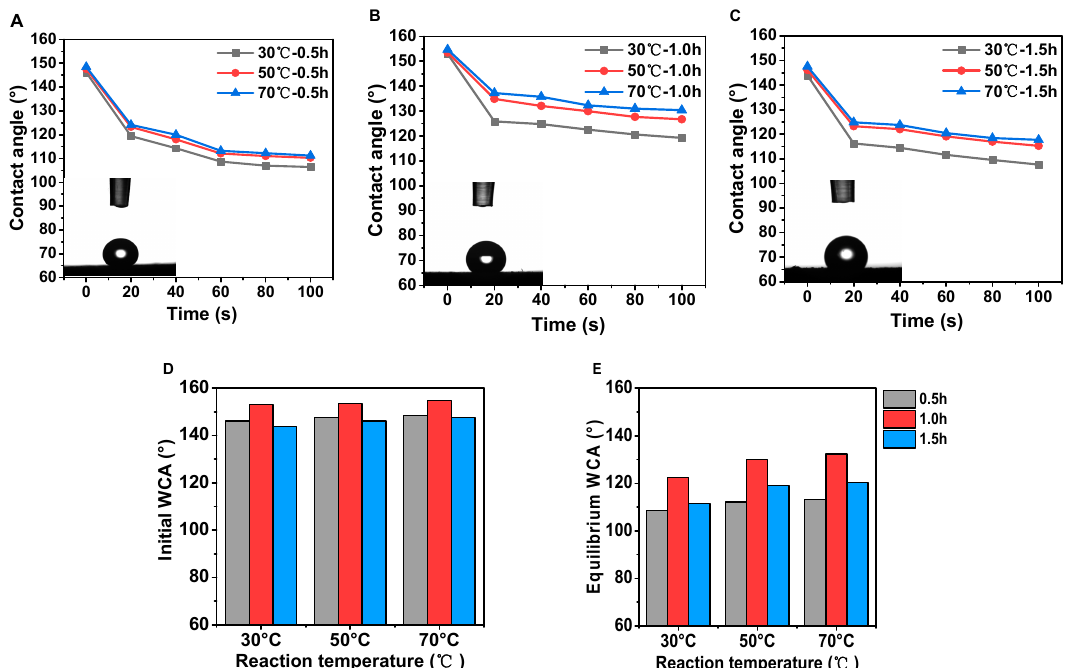
Figure 10. The water CAs of PDMS@wood on cross section. The different reaction temperature with durations of ( A ) 0.5 h, ( B ) 1 h, and ( C ) 1.5 h. The comparison of CAs at ( D ) initial and ( E ) equilibrium after 60 s.